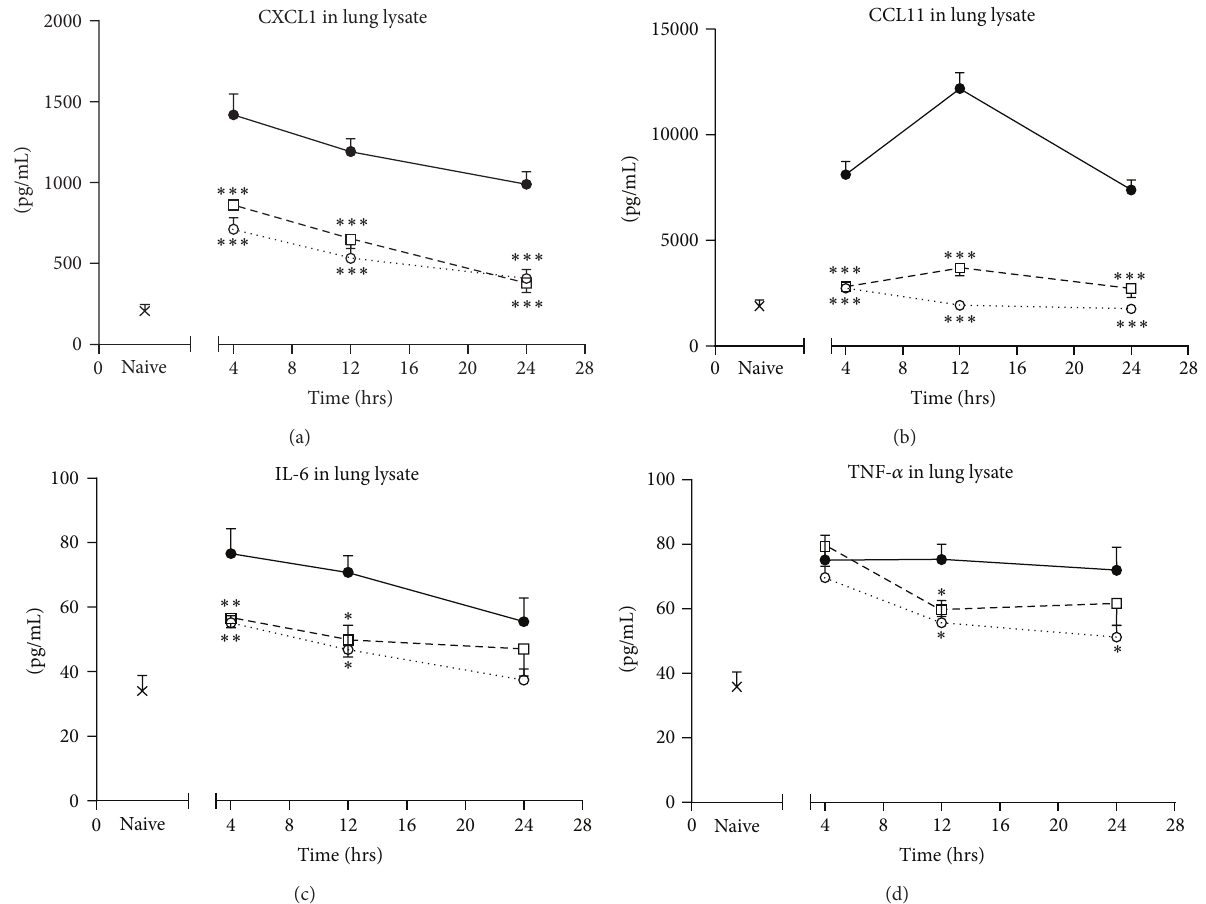
Figure 4: Effects of drug treatment on production of proinflammatory cytokines (a) CXCL1, (b) CCL11, (c) IL-6, and (d) TNF- 𝛼 in lung tissue lysate. Animals were treated with vehicle (— e —), ISU201 (-- ◻ --), or dexamethasone ( ⋅⋅⋅ I ⋅⋅⋅ ) at 2 and 8 hours after induction of an exacerbation. Data are mean ± SEM ( 𝑛 = 6 animals per group). Significant differences relative to vehicle-treated animals at each time point are shown as ( ∗ 𝑃 < 0.05 ), ( ∗∗ 𝑃 < 0.01 ), and ( ∗∗∗ 𝑃 < 0.001